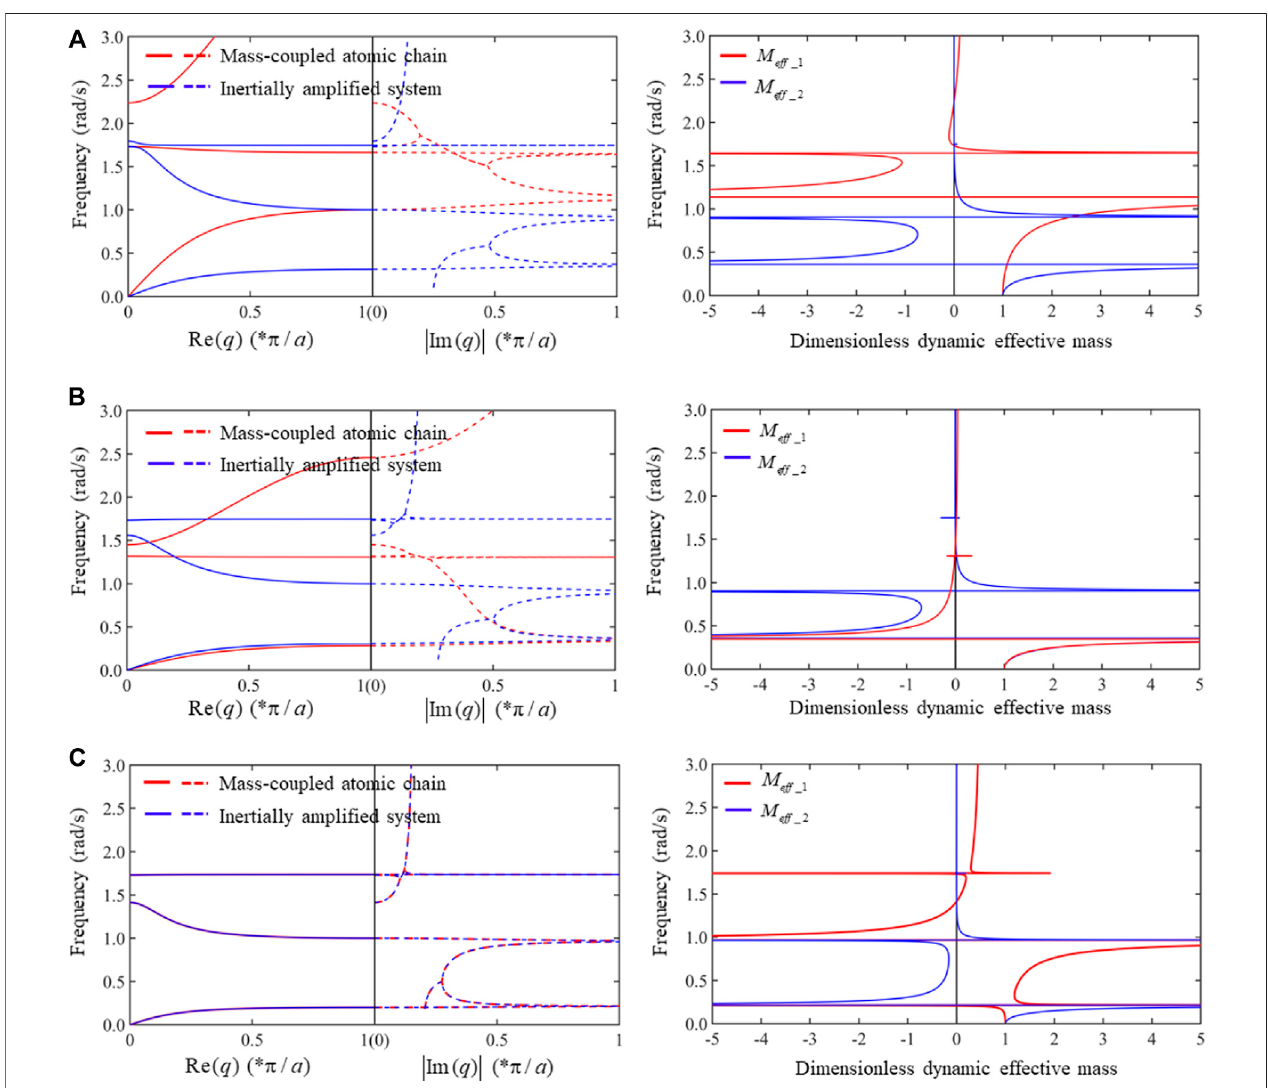
FIGURE11| Bandstructuresofthemass-coupledmonatomic/triatomicchainsandinertialampli fi cationsystemsof3-DOFandtheircorrespondingdimensionless dynamic effective masses. The parameters are listed as follows: (A) k 1 (cid:2) k 2 (cid:2) k 3 (cid:2) 1 , k (cid:2) 2 , M (cid:2) 0 . 5 , m 1 (cid:2) m 2 (cid:2) 1 , m a (cid:2) 0 . 4 , θ (cid:2) π /18 , . (B) k 1 (cid:2) k 3 (cid:2) k (cid:2) 1 , k 2 (cid:2) 10 , M (cid:2) 1 , m 1 (cid:2) 15 , m 2 (cid:2) 10for the mass-coupled atomic chain and k 1 (cid:2) k 2 (cid:2) k 3 (cid:2) 1 , M (cid:2) m 1 (cid:2) m 2 (cid:2) 1 , m a (cid:2) 0 . 4 , θ (cid:2) π /18for the inertial ampli fi cation system, (C)